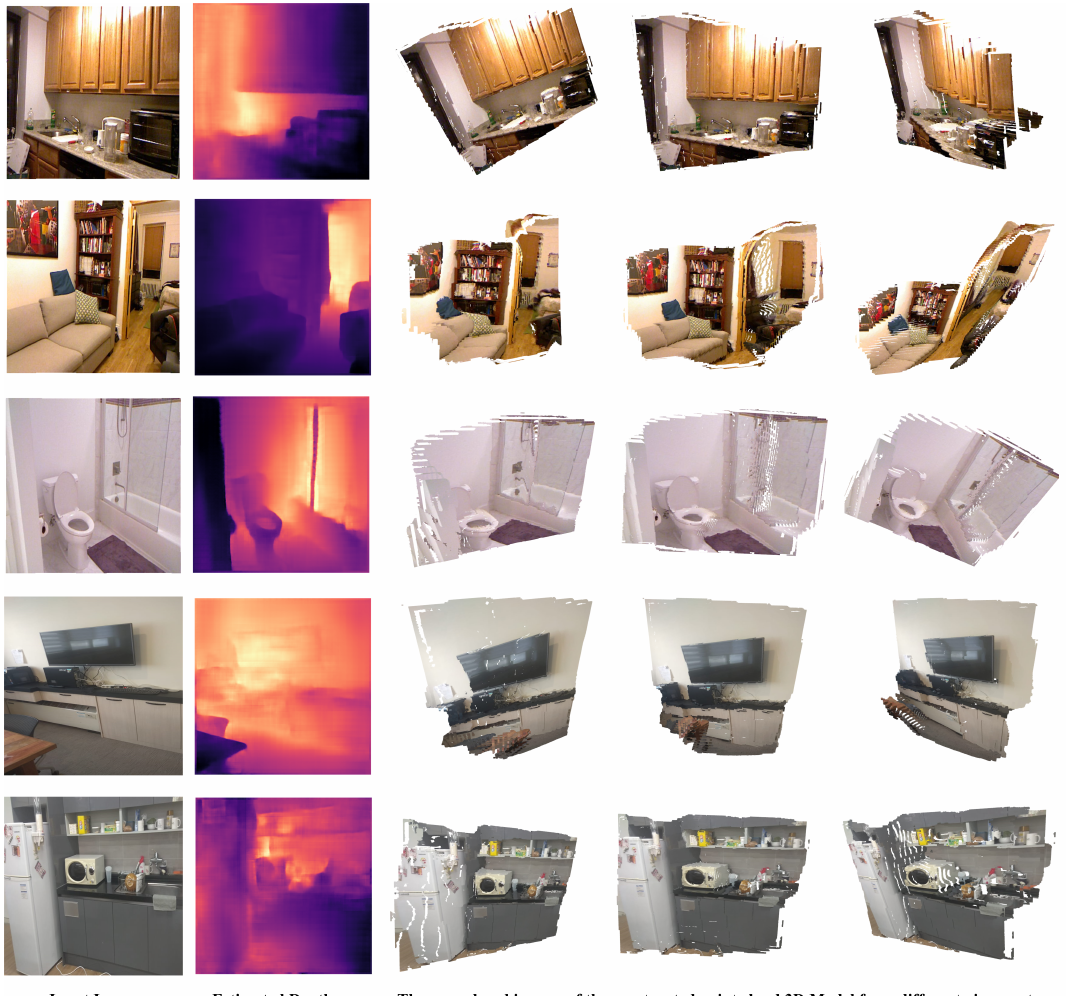
Figure 6. Three dimensional (3D) reconstruction results that were obtained using our method (ViT- t16+Deconv). The input image and the estimated depth for each sample are used to construct a point cloud following Equations (4)–(6). Three rendered images of each sample from different viewpoints are shown to the right of the estimated depth. The first three images (in the most left column) are samples from NYU depthV2 and the bottom two images are images taken from our